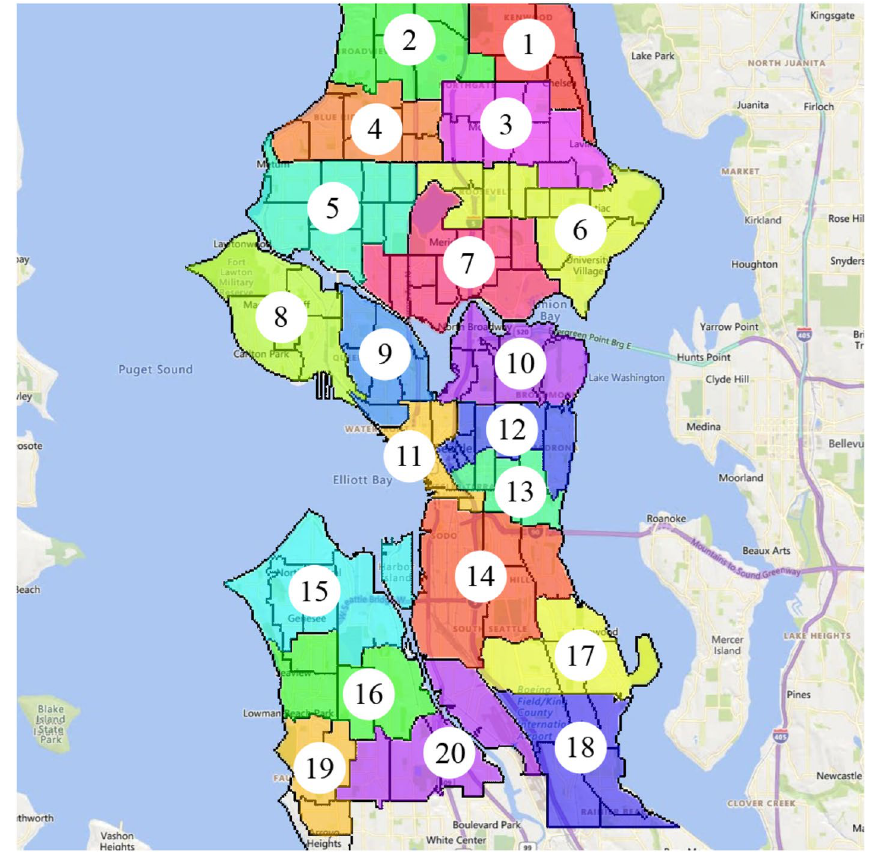
Figure 4. Seattle case study areas and census tracts 39